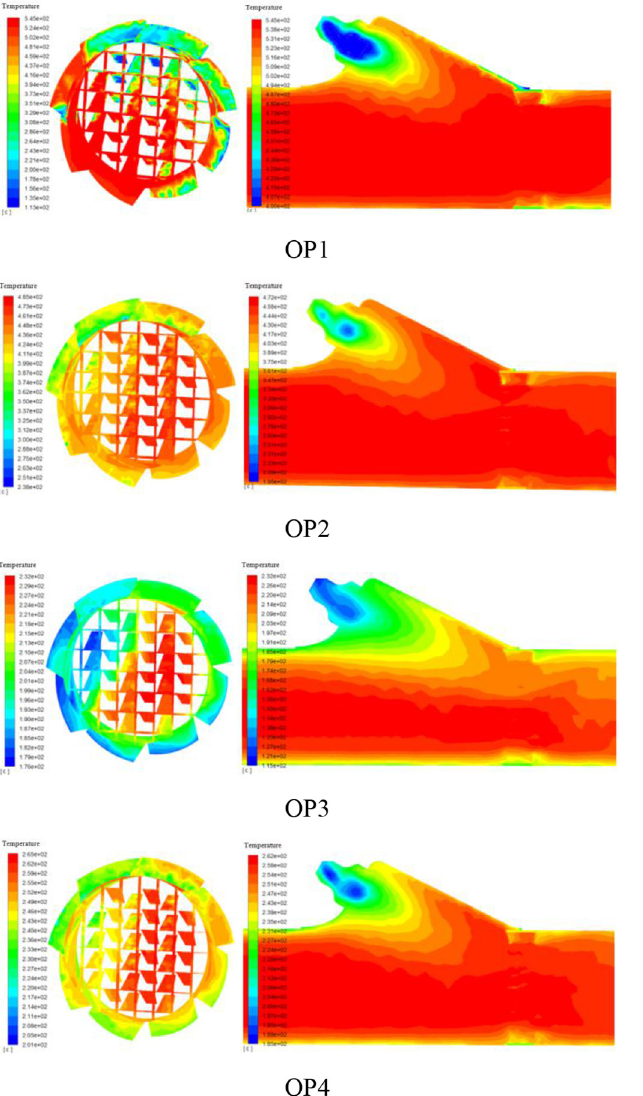
Fig. 14. Temperature distribution at the mixing part.